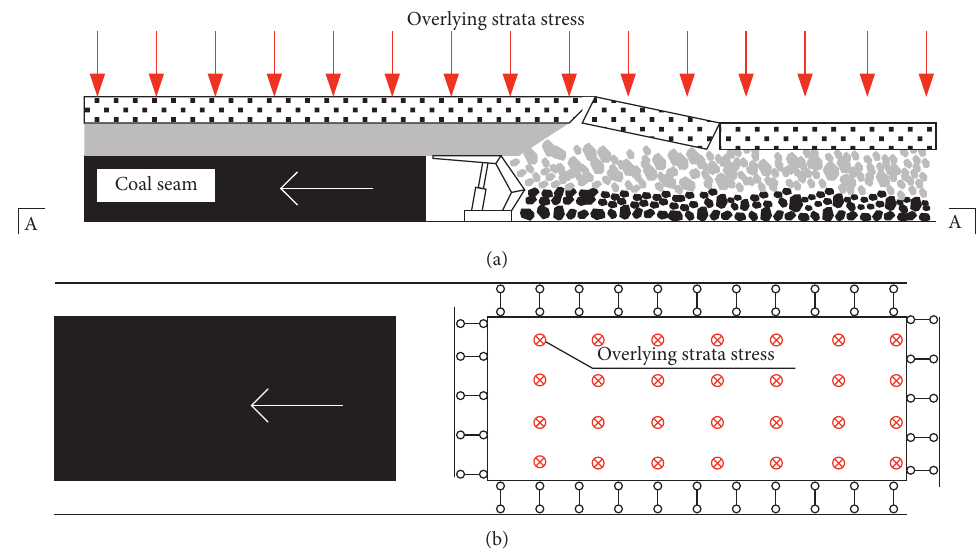
Figure 2: The stress state of the coal in gob. (a) Working face direction stress. (b) Stress in